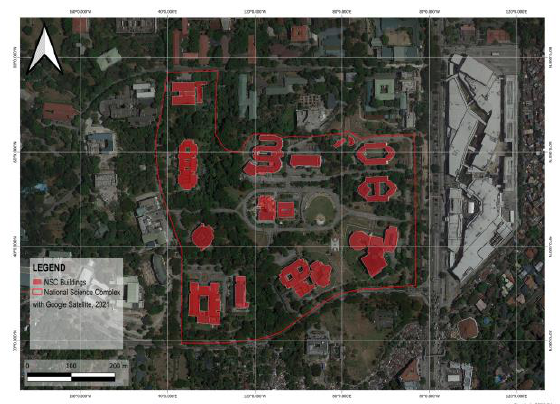
Figure 1. The National Science Complex (NSC) in UP Diliman, Quezon